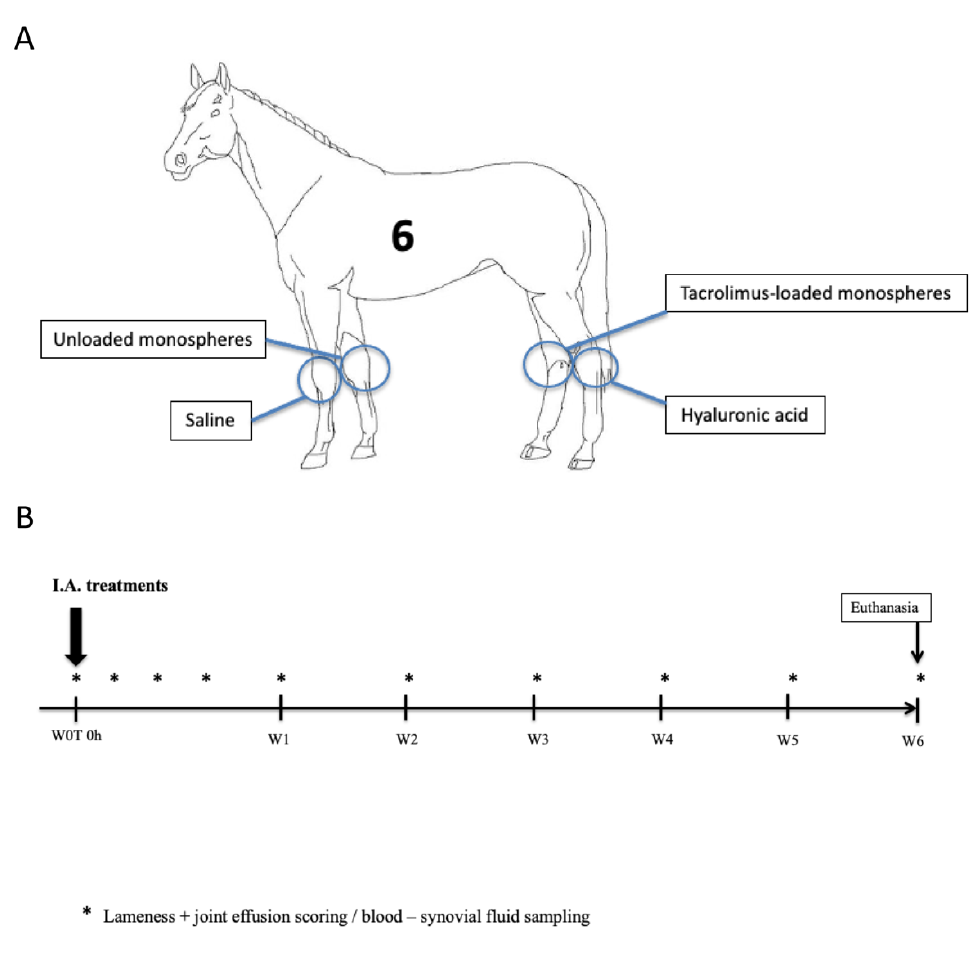
Figure 1. Schematic view of intra-articular treatments in each of the 6 horses ( A ). Unloaded mono- spheres were administered into the right middle carpal joint and tacrolimus-loaded monospheres were injected into the right talocrural joint. Saline was injected into the left middle carpal joint as a negative control. HA was injected into the left talocrural joint as a positive control. The timeline shows an overview of the 6-week study period ( B ).